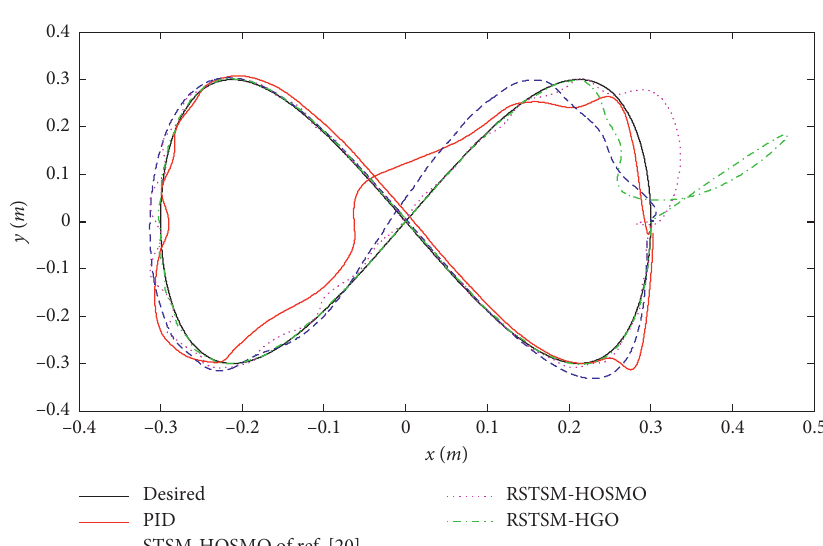
Figure 4: Eight-shaped reference trajectory tracking response